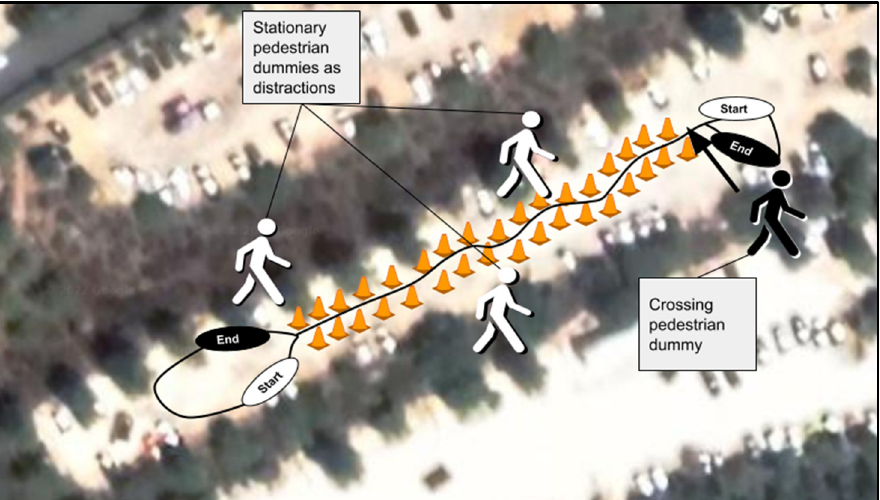
Figure 5. Driving route (for both remote driving and simulated driving conditions), consisting of road cones marking a slalom route with stationary pedestrian dummies as distractions, a U-turn marking and a crossing pedestrian dummy stress manipulation.